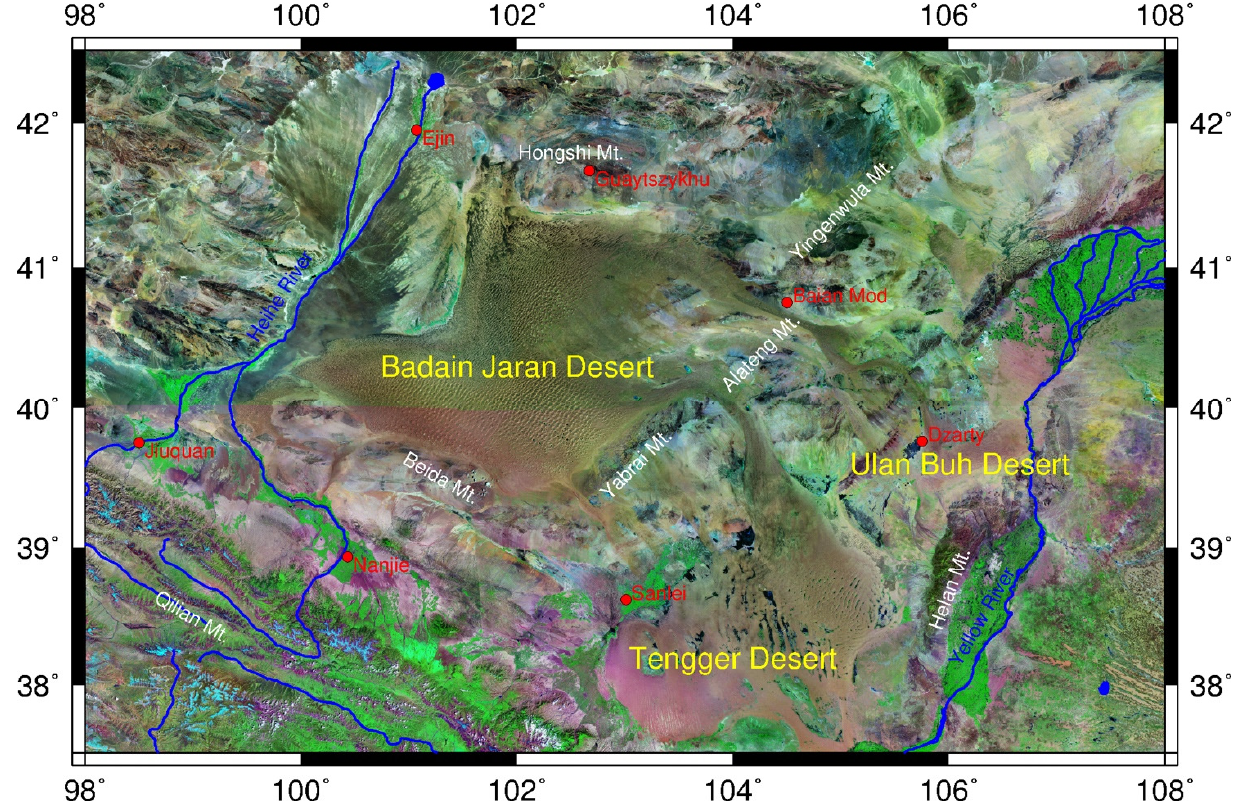
Figure 1. Location of the study area. The purple dots indicate the locations of meteorological stations. The red rectangle in the lower left shows the position of the study area in China. The background Landsat imagery was downloaded from the Geospatial Data Cloud (http://www.gscloud.cn/, accessed on 11 February 2021).